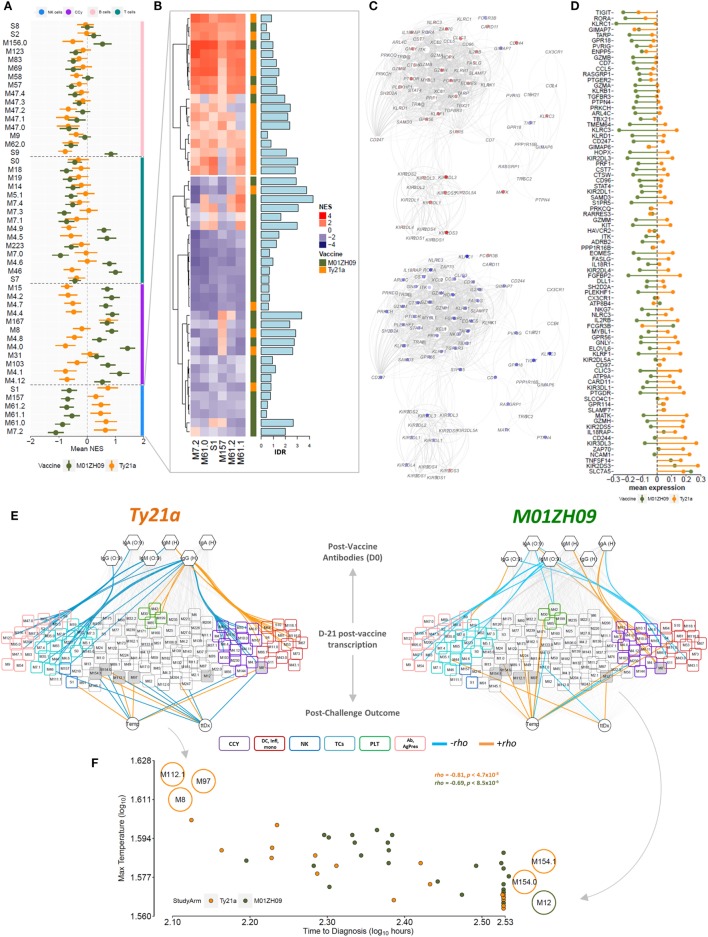
Single sample GSEA (ssGSEA) following vaccination at time point D-21. (A) Normalized enrichment score (NES) (mean + SEM) of blood transcriptional modules (BTMs) related to NK cells (blue bar), the cell cycle (purple), B cells (pink bar), and T cells (cyan bar) across all participants in the Ty21a (orange) and M01ZH09 (green) arm at time point D-21 after vaccination is plotted. (B) Tile graph representing the NES for all NK cell-related BTMs for each participant (red: positive NES; blue: negative NES). Color bar on the right represents the vaccine group membership. Bar graph along the tile graph signifies the heterogeneity within each participant (depicted by inter-decile range). (C) NK cell modules were combined into one network and superimposed with mean gene expression values at time point D-21 following Ty21a (top) and M01ZH09 (bottom). (D) Mean expression of genes within the NK cell-related BTMs in the Ty21a and M01ZH09 group at time point D-21 following vaccination. (E) Association networks. NESs derived from the ssGSEA at time point D-21 were correlated with antibody responses to vaccination and parameters reflecting outcome following challenge [temperature (Temp); time to diagnosis (ttDx)] in Ty21a (left) and M01ZH09 (right) recipients. BTM colors: purple: cell cycle. Blue: NK cells. Cyan: T cells. Red: inflammation, monocytes, and dendritic cells. Pink: antibodies, B cells, and antigen presentation. Green: platelet activation. Colors of edges represent significance level and Spearman’s rank correlation coefficients (orange: p < 0.05, rho > 0; blue: p < 0.05, rho < 0; gray: n.s.). Gray shaded nodes: BTMs associated with post-challenge outcomes. (F) Correlation plot of maximum Temp following challenge and ttDx. Modules indicated on the plot represent modules inversely associated with Temp and ttDx. Top left: positive and negative correlation with Temp and ttDx, respectively. Bottom right: positive and negative correlation with ttDx and Temp, respectively. Orange: Ty21a recipients; dark green: M01ZH09 recipients.